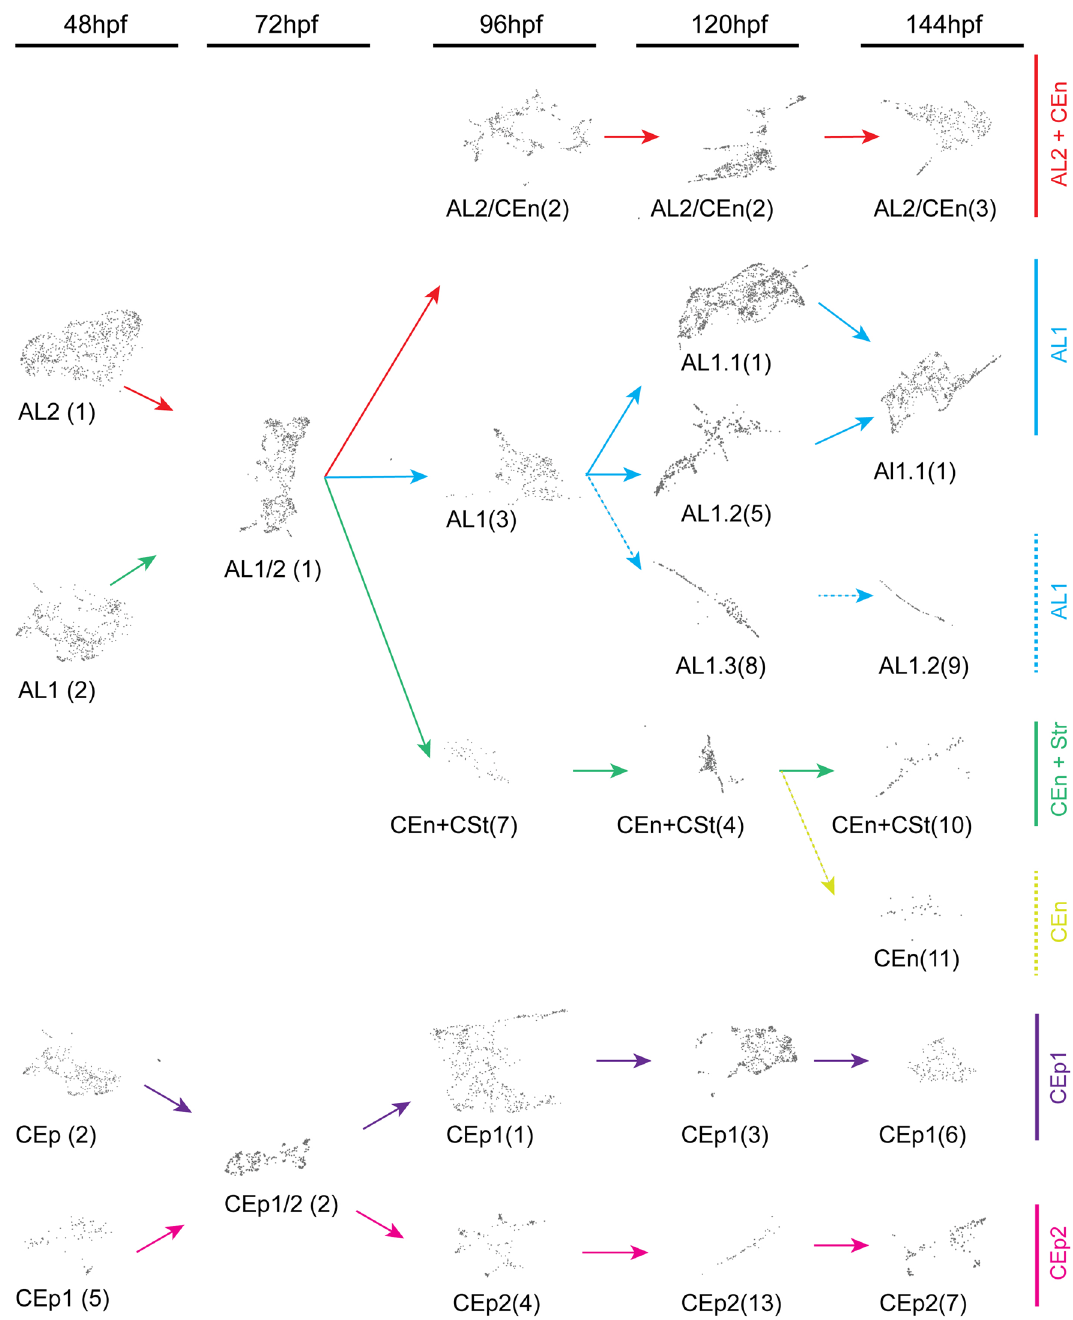
Figure 5. Cluster trajectories during early development of corneal epithelium, endothelium, stroma, and annular ligament. Developmental trajectories of individual clusters from each timepoint, 48–144 hpf, displaying temporal relationships. Numbers in brackets correspond to timepoint specific clusters (Fig. 3). Arrows indicate lineage relationships of the AL1 (blue), AL2/CEn (magenta), AL1/CEn + CSt (blue), CEn (light blue), CEp1 (purple) and CEp2 (pink) cell types. CEp lineages show early and dedicated commitment while AL lineages display multipotency for AL, CEn or CSt cell